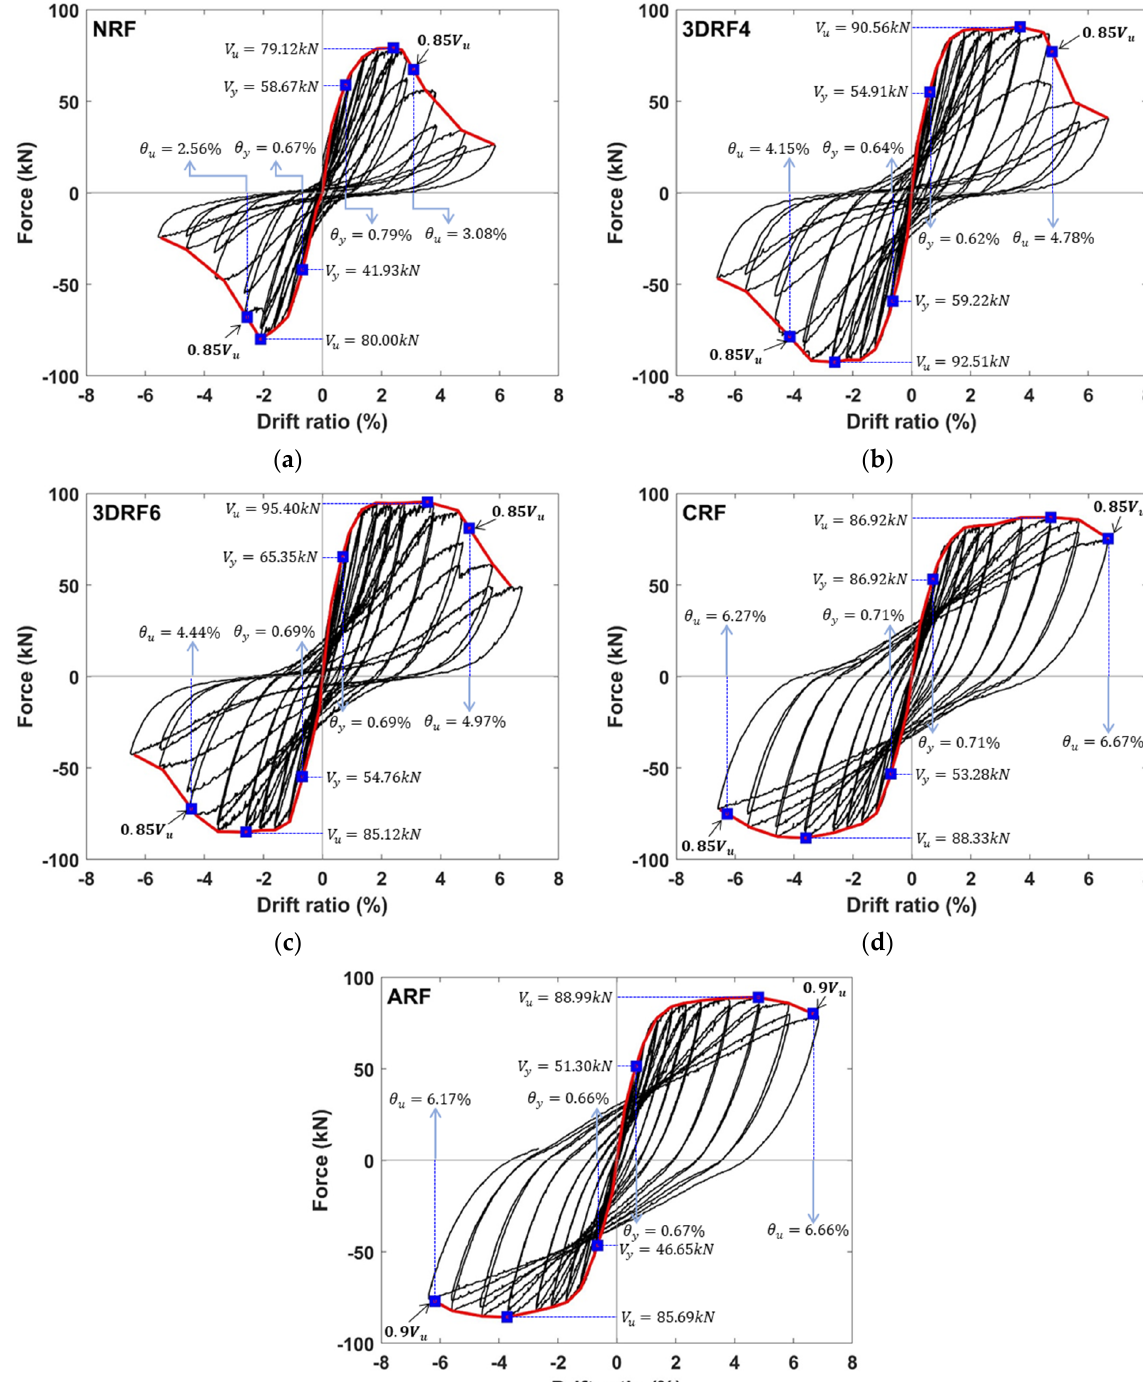
Figure 10. Lateral force and drift ratio: ( a ) NRF; ( b ) 3DRF4; ( c ) 3DRF6; ( d ) CRF; ( e ) ARF.